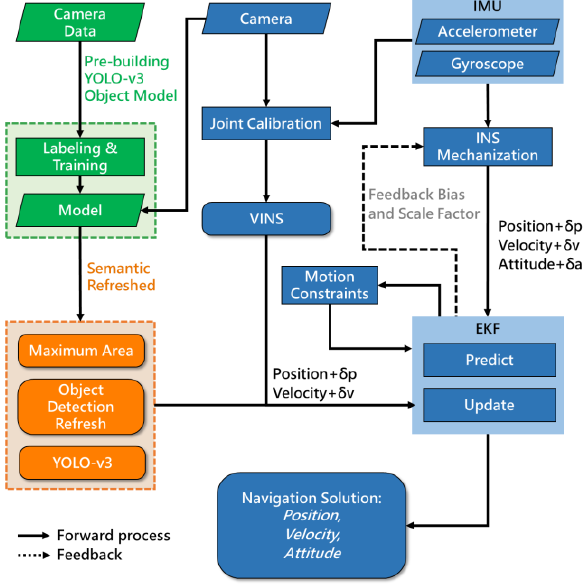
Figure 5. The proposed semantic refreshed INS/VINS/ODR